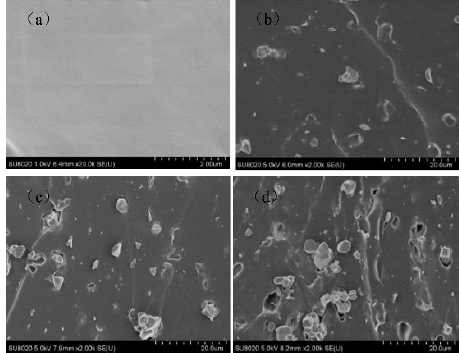
Figure 3. SEM morphology of the fresh surfaces of EPDM and composites with different CCTO